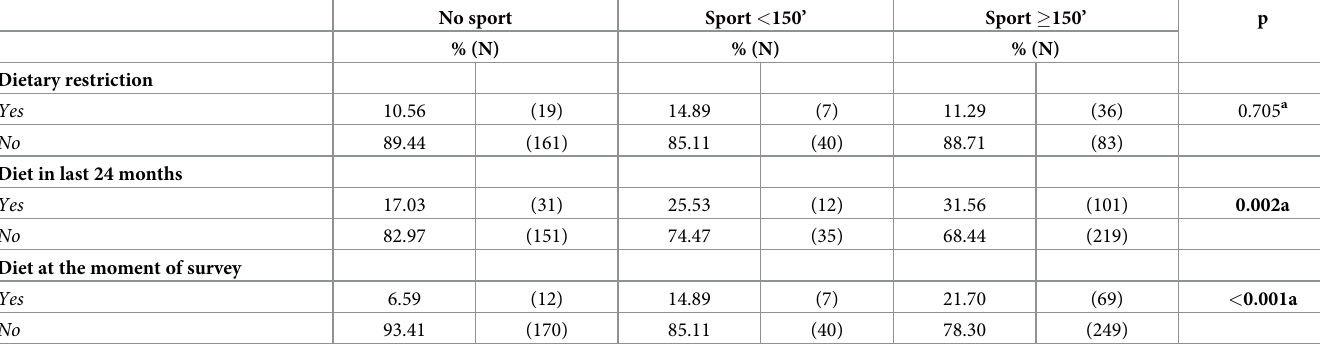
Table 2. Nutritional habits of sample, stratified by minutes of sport activity during the